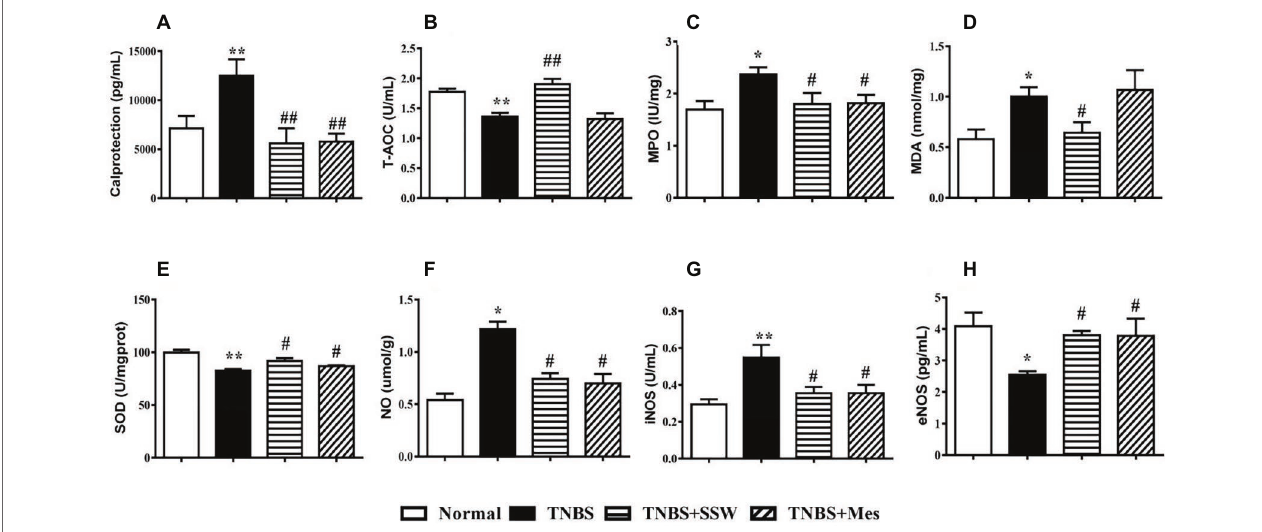
FIGURE 2 | Level of calprotectin and antioxidants. (A) Calprotectin; (B) T-AOC; (C) MPO; (D) MDA; (E) SOD; (F) NO; (G) iNOS; (H) eNOS. Data were presented as mean ± SEM ( n = 8). * p < 0.05 and ** p < 0.01 versus the Normal group; # p < 0.05 and ## p < 0.01 versus the TNBS group.